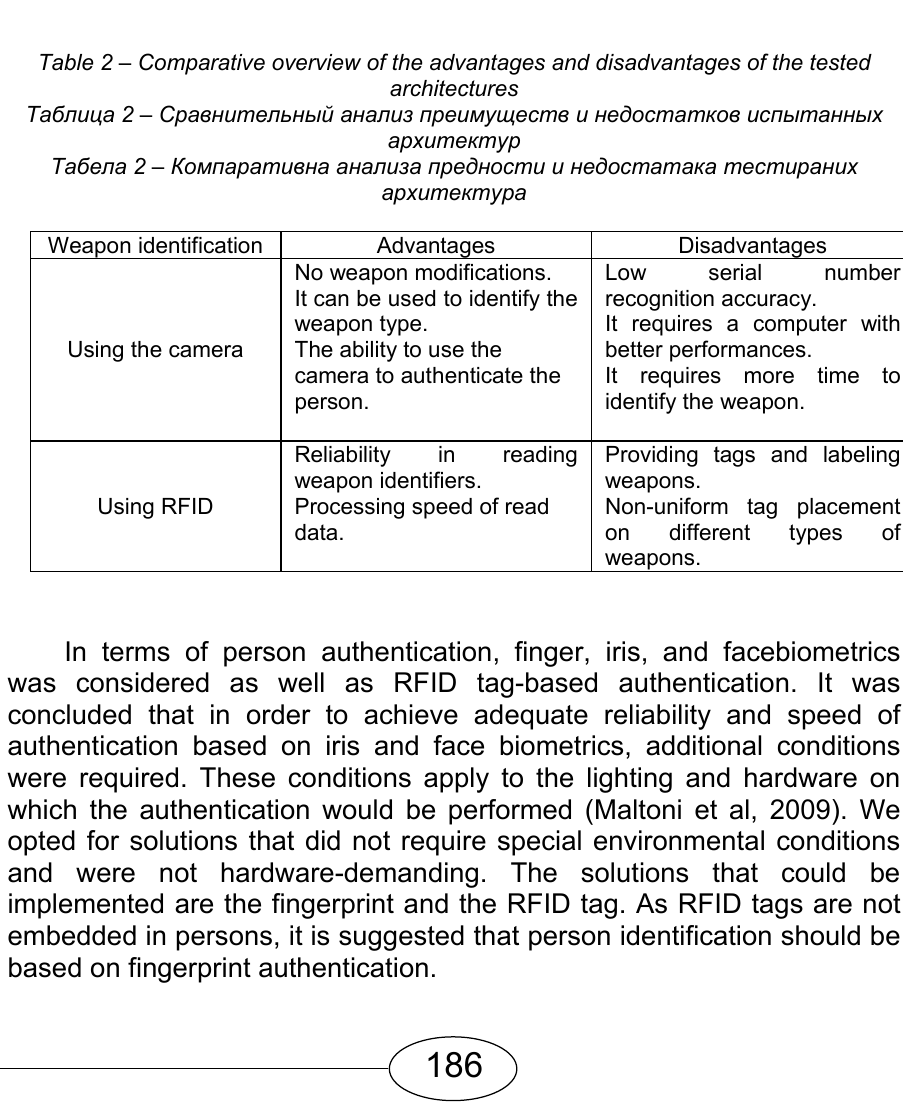
Table 2 – Comparative overview of the advantages and disadvantages of the tested